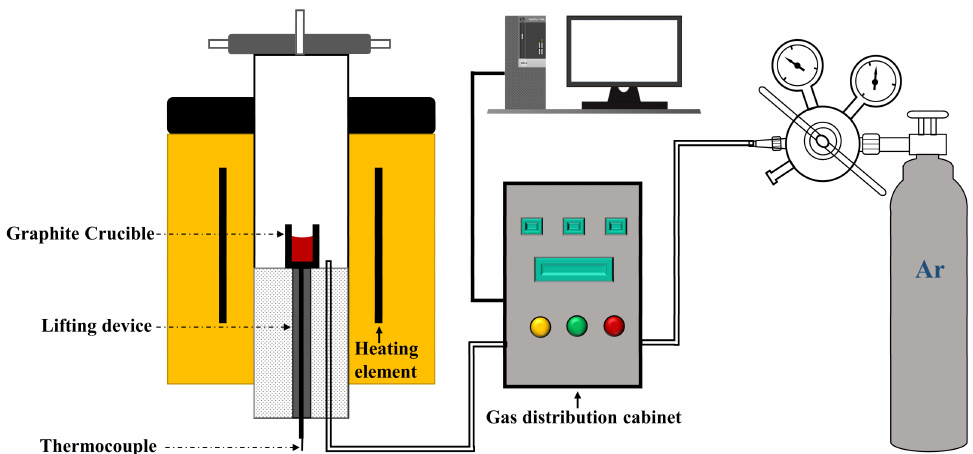
Figure 2. Schematic diagram of the experimental